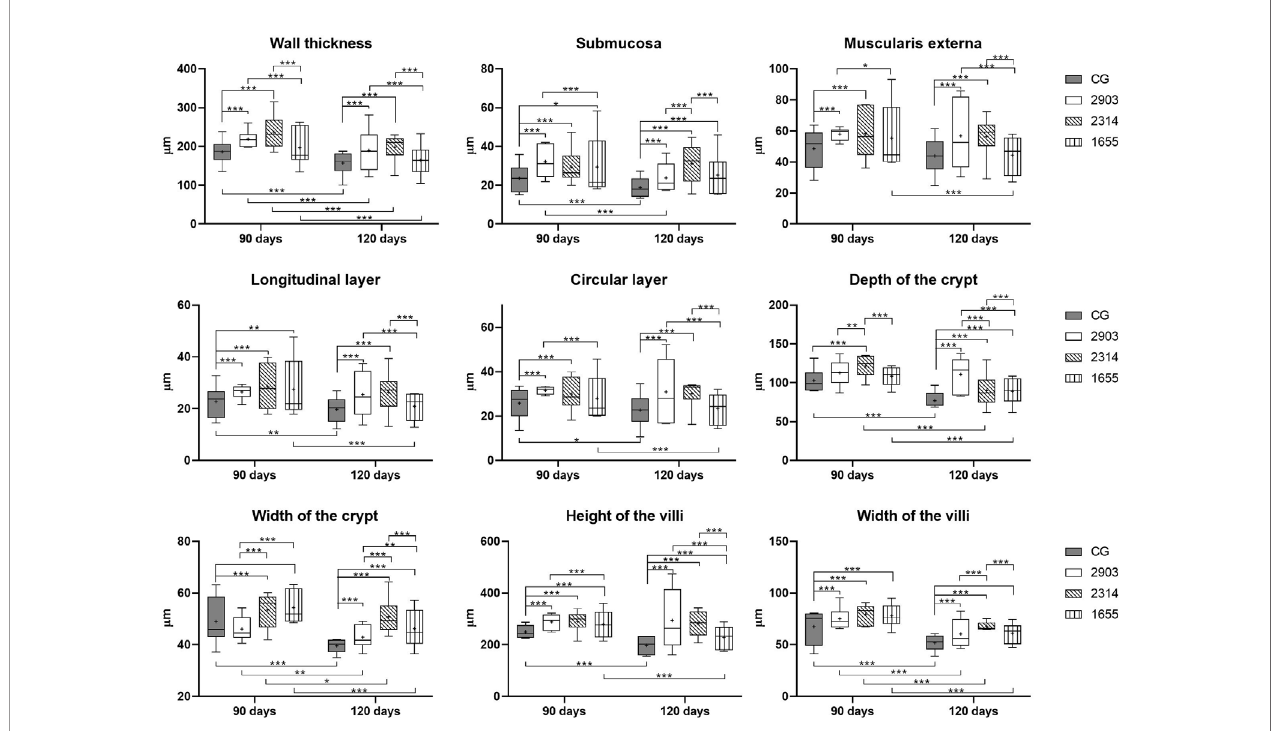
FIGURE 4 | Morphometry of wall, villi, and crypts of ileums of hamsters infected by L. (V.) braziliensis for 90 or 120 days (μm). Data represented in box plots (median with 25 to 75 percentile), whiskers (2.5 to 97.5 percentile), and mean (+) ( n = 6). * p < 0.05; ** p < 0.01; *** p < 0.001. CG, control group. 2903: group infected with MHOM/BR/1975/M2903. 2314: group infected with MHOM/BR/2003/2314. 1655: group infected with